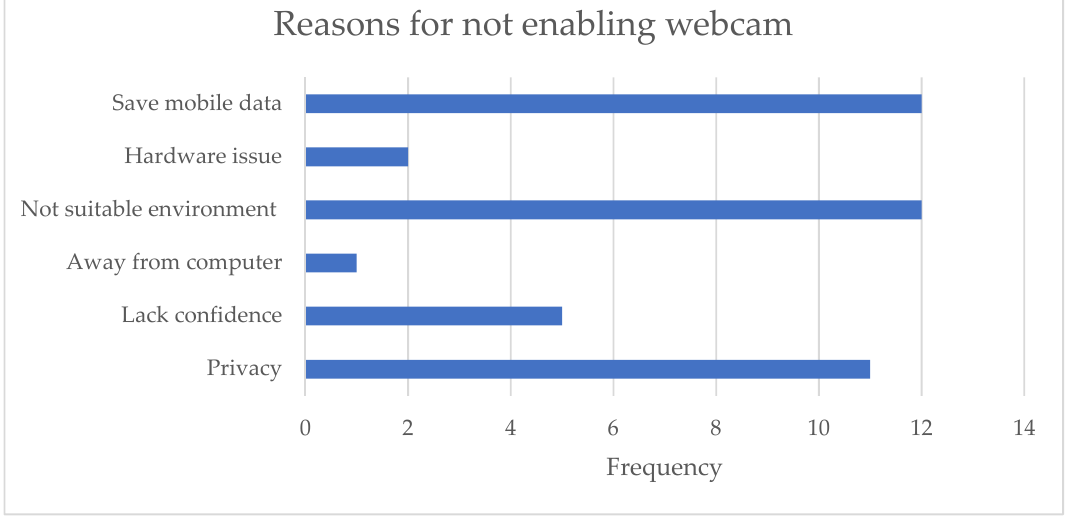
Figure 5. Top reasons for disabling the web camera during virtual conferences. The participants in the usability study were also asked when they would be willing to turn on the web camera. It was discovered that participants neither enabled nor disabled the web camera continuously. The participants stated that they usually enabled the web camera “when being asked”, which rated the highest. The second most important factor influencing whether they switched on the web cameras was having to “give a presentation”, followed by “performing group activity”. Figure 6 shows the results of different situations in which participants were willing to turn on their web cameras during a video conference meeting.